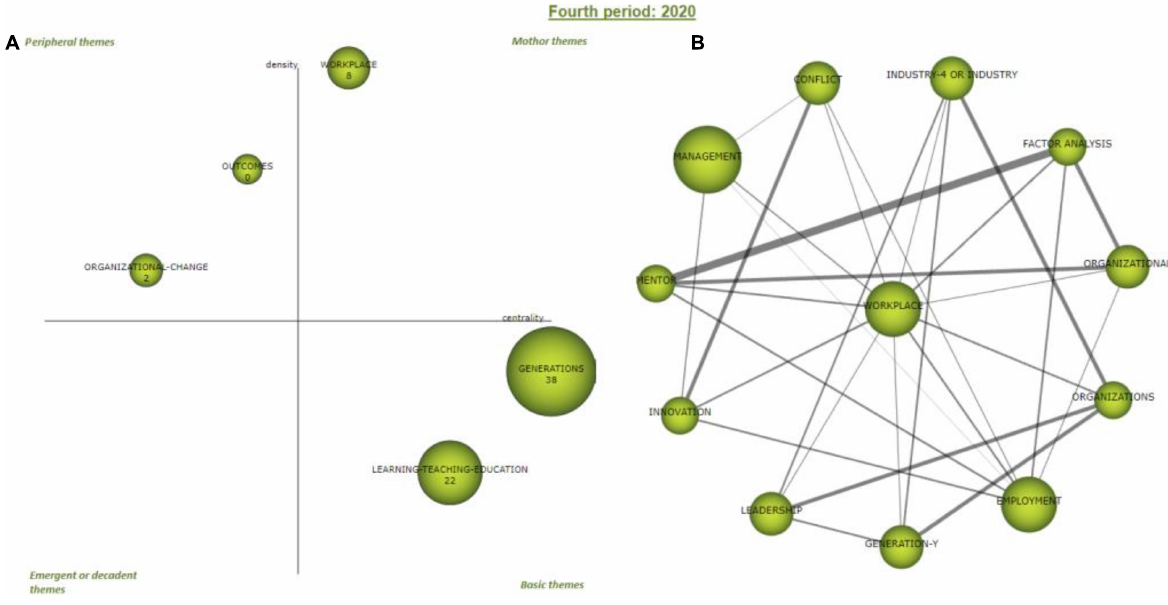
Frontiers in Psychology |